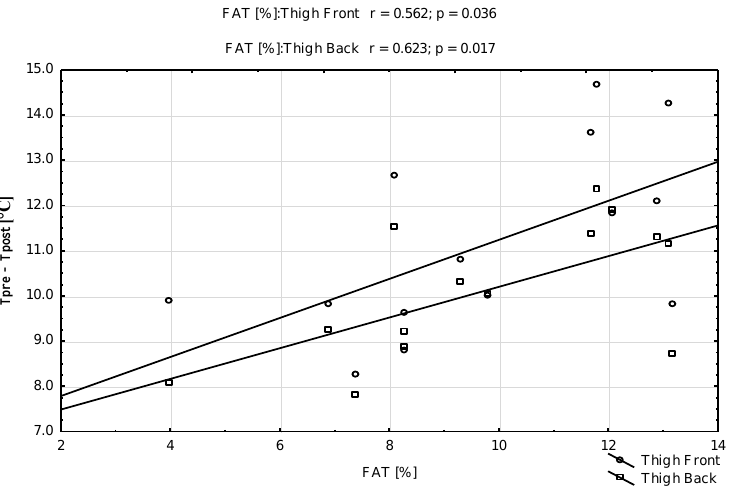
Figure 4. Relationship between body fat percentage and the magnitude of change in temperature of the anterior and posterior surfaces of the thighs.